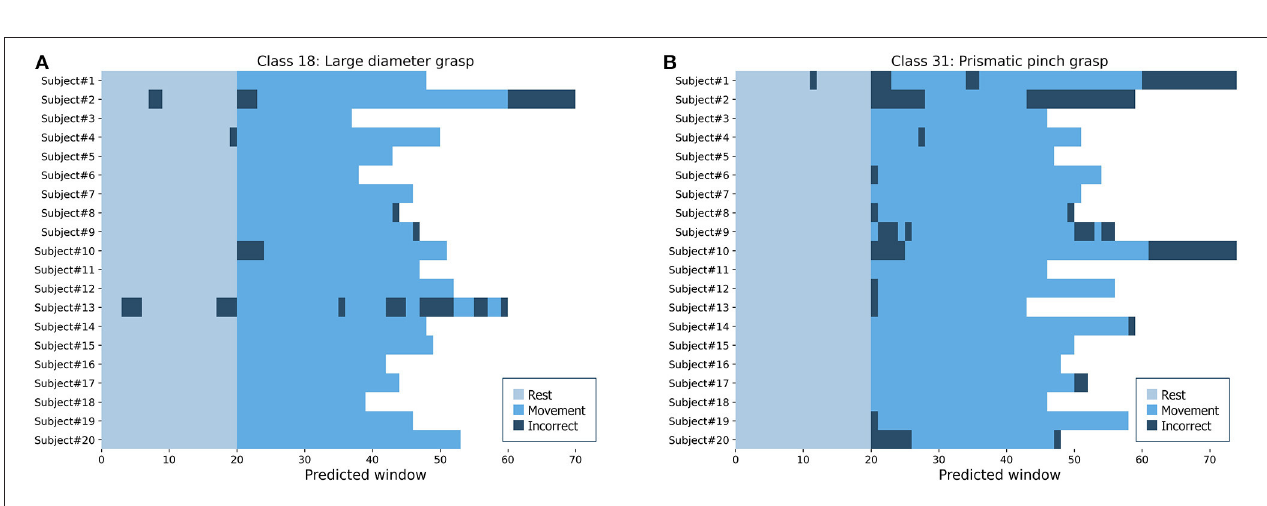
FIGURE 10 | Predicted sequences of full repetitions for every intact participant from DB7 (A) the large-diameter grasp (class 18) (B) the prismatic pinch grab (class